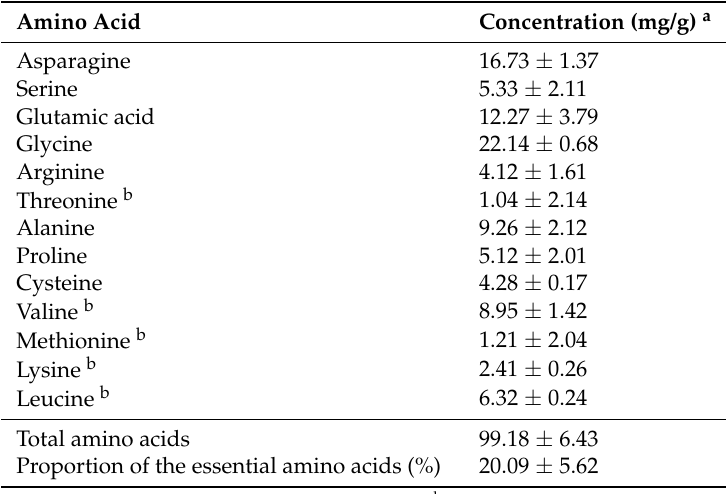
Figure 1. Atomic force microscopy (AFM) image of B. exarata polysaccharide-protein complex BEPS-IA was obtained with a Nano Scope III atomic force microscope and collected by tapping mode atomic force microscopy. The BEPS-IA concentration was 1 μ g/mL. ( A ) Topographic image of a 90 min BEPS-IA sample taken by AFM in air at room temperature; ( B ) 3D visualization of BEPS-IA polymer reveal thin and thick polymer portions corresponding to areas highlighted with arrows in ( A ). Table 1. The amino acid composition of BEPS-IA.